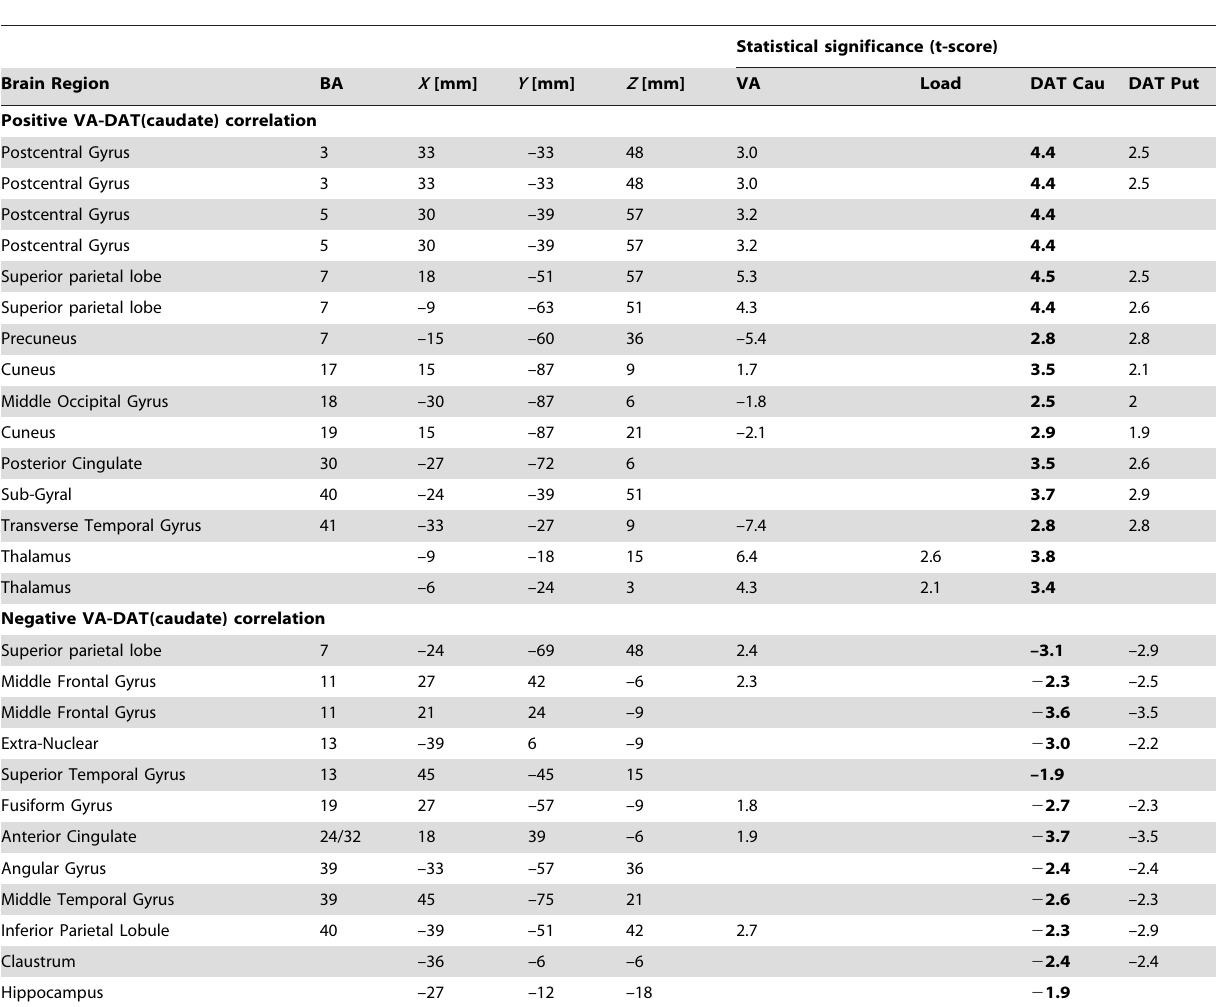
Table 3. Average statistical significance in regions-of-interest exhibiting correlations between BOLD-fMRI signals and DA transporters in